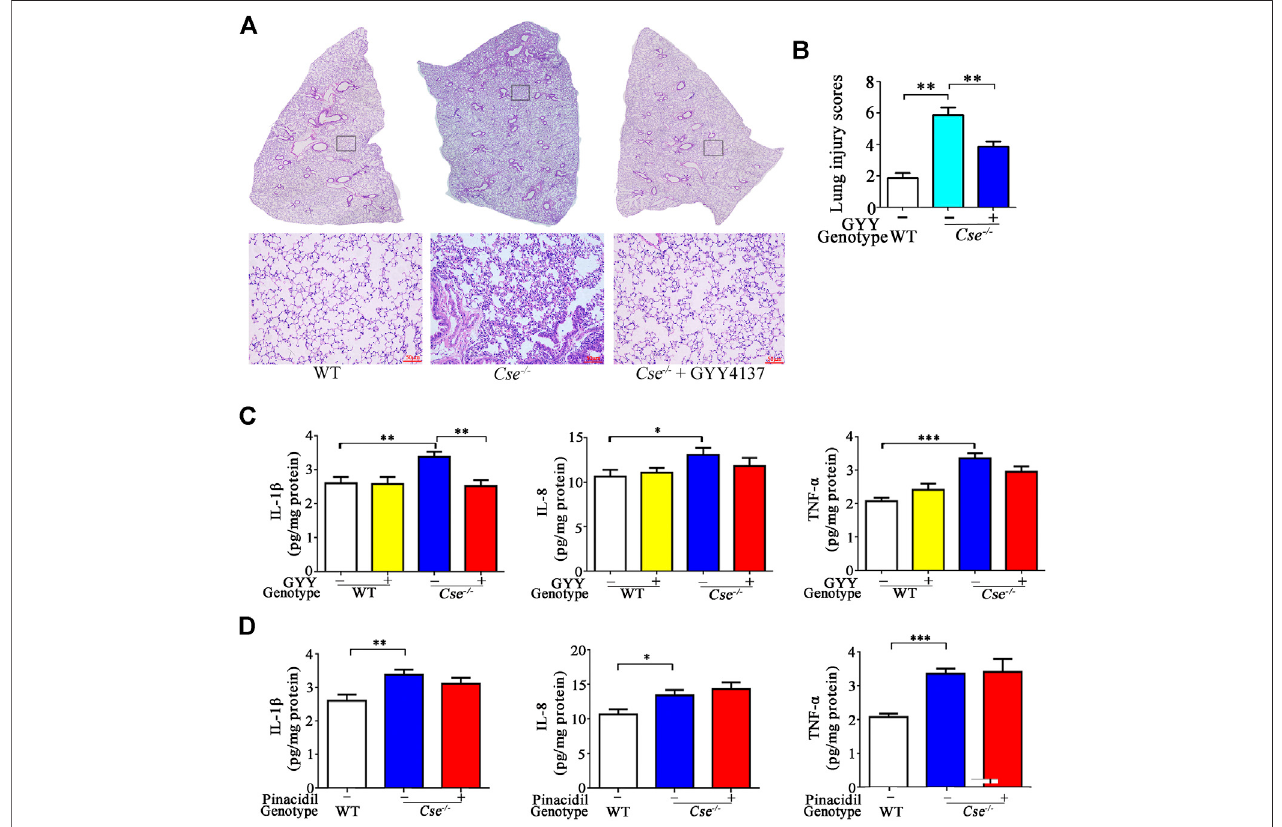
FIGURE5| GYY4137treatmentamelioratespathologicalalternationandinhibitsin fl ammationinlungtissuesin Cse -/- mice.WTand Cse -/- micewereadministered with saline, GYY4137 (50mg/kg) or pinacidil (2.8 μ mol/kg). Twenty-four hours after injection, the mice were sacri fi ced, and the lung tissues were then collected for morphological analysis and determination of proin fl ammatory cytokines. (A) , representative images of H&E staining of lung tissues of WT and Cse -/- mice with saline or GYY4137 treatment. (B) , cumulative data of lung injury scores of WT and Cse -/- mice with saline or GYY4137 treatment. Data were expressed as mean ± SEM; n (cid:2) 8pergroup. (C) ,IL-8,IL-1 β andTNF- α levelsinlungtissuesofWTand Cse -/- micewithsalineorGYY4137treatment.DatawereexpressedasMean ± SEM; n (cid:2) 8per group. (D) ,IL-8,IL-1 β ,andTNF- α levelsinlungtissuesofWTand Cse -/- micewithsalineorpinacidiltreatment.Dataareexpressed asmean ± SEM; n (cid:2) 8 –